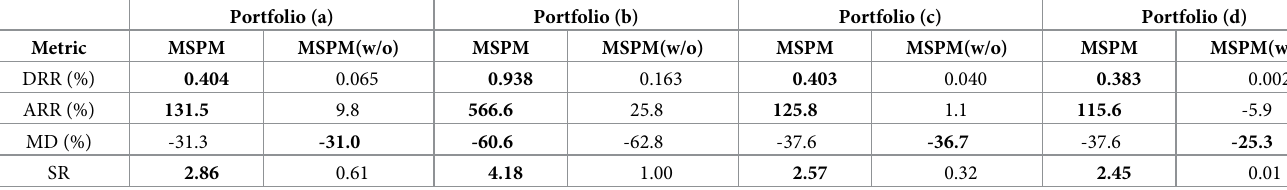
Table 6. Comparison of back-testing performance of EAM-enabled and EAM-disabled MSPMs. Portfolio